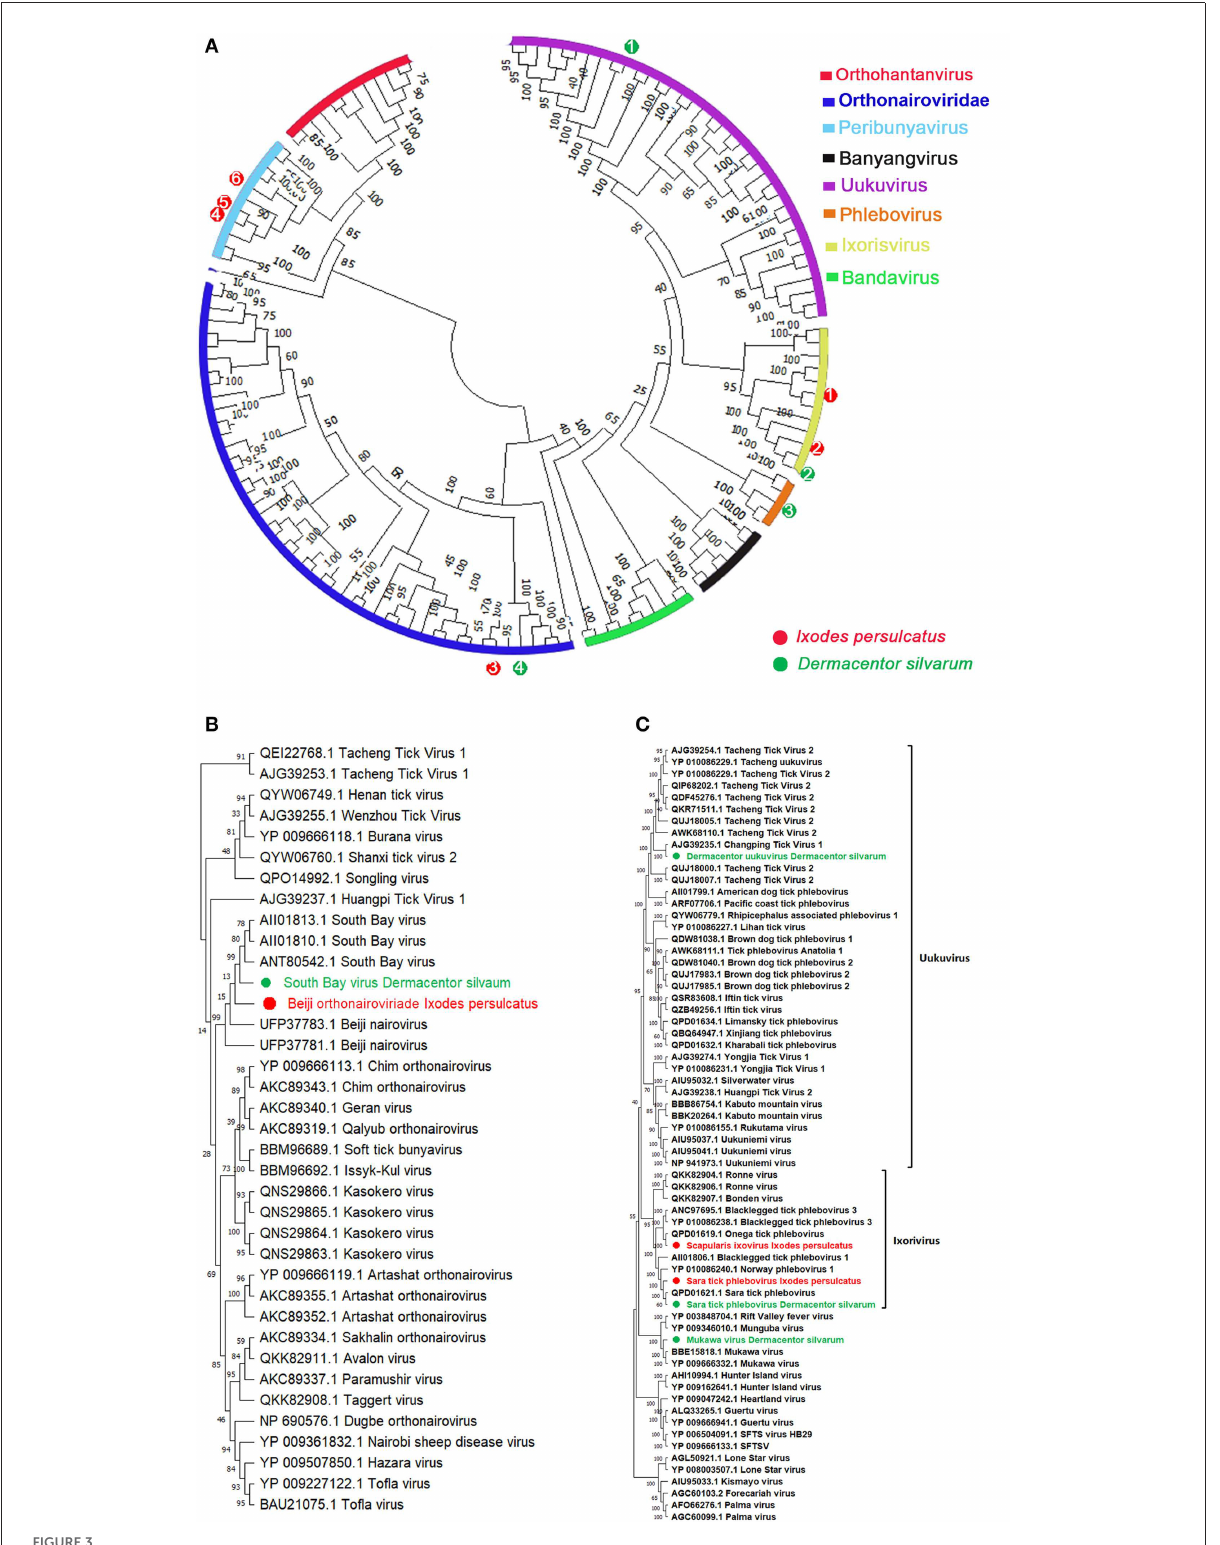
FIGURE3 Phylogenetic analysis of representative branches in the order Bunyavirales. (A) Alignment of all branches belonging to the order Bunyavirales . (B) Enhanced region showing Phenuiviridae members. (C) Enhanced region showing Orthonairoviridae members. Red dots marked with 1 to